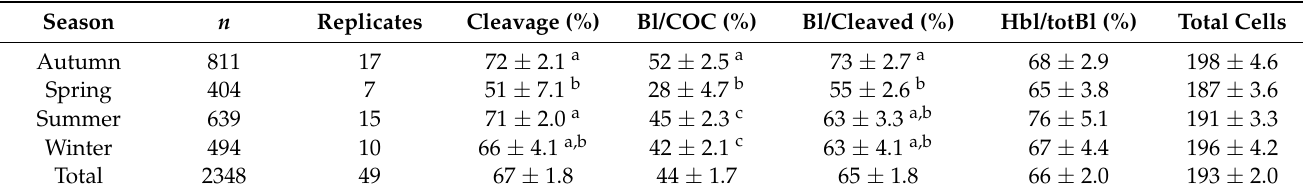
Table 1. Effect of different seasons on developmental competence of adult goat oocytes derived from slaughterhouse ovaries. Percentages of cleavage, blastocysts (Bl), and hatched embryos in relation to the total blastocysts (Hbl/totBl), and blastocyst cell counts (Mean ±